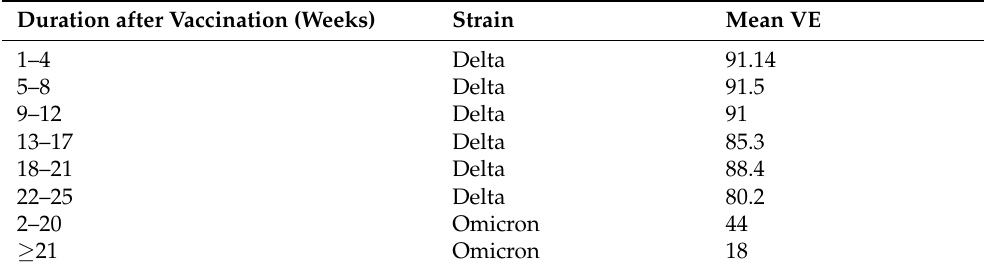
Table 2. Vaccine effectiveness from time after vaccination after the second dose. Duration after Vaccination